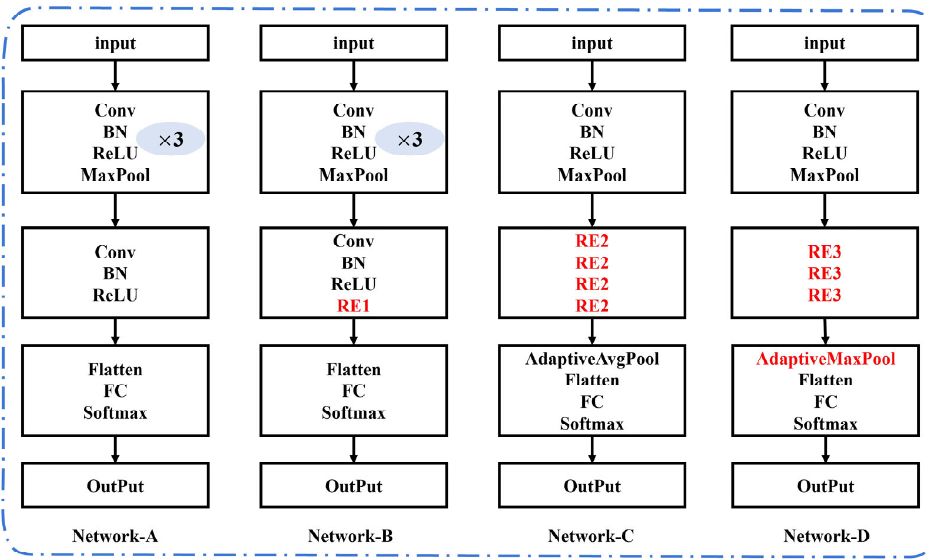
Figure 6. Structure diagram of four network models.